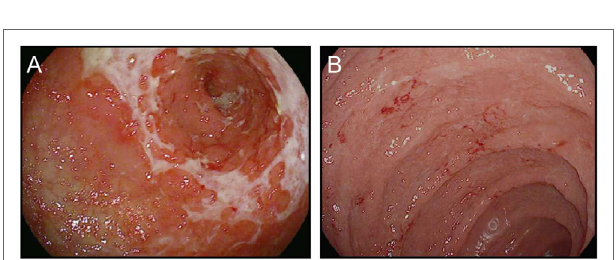
FiGURe 2 | Ipilimumab colitis with isolated deep ulceration. (a,B) high resolution photograph of the colon of a patient with ipilimumab-associated colitis showing an isolated deep ulceration typical of Crohn’s disease (a) or similar ulcers found in a patient with “sporadic” Crohn’s disease (B) .